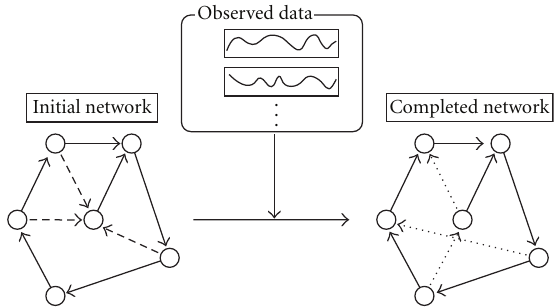
Figure 1: Network completion by addition and deletion of edges. Dashed edges and dotted edges denote deleted edges and added edges, respectively.